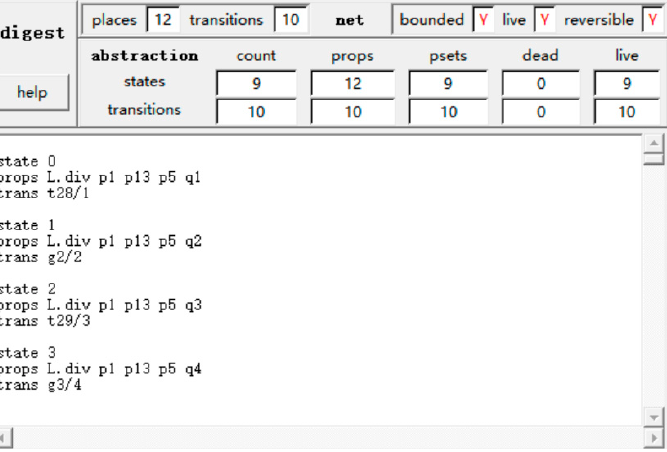
Figure 10. The reduced smart restaurant model Σ 2 = { N 2 , F 2 , G 2 , M 2 } in Tina.